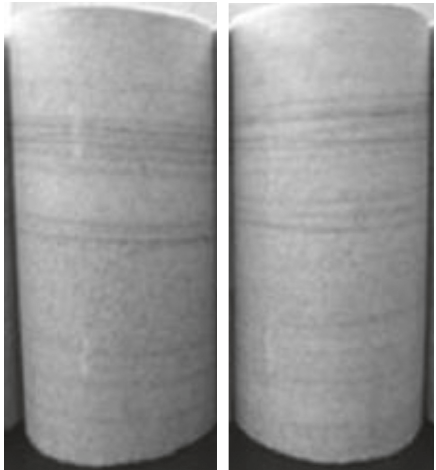
Figure 2: Typical test sample photo.